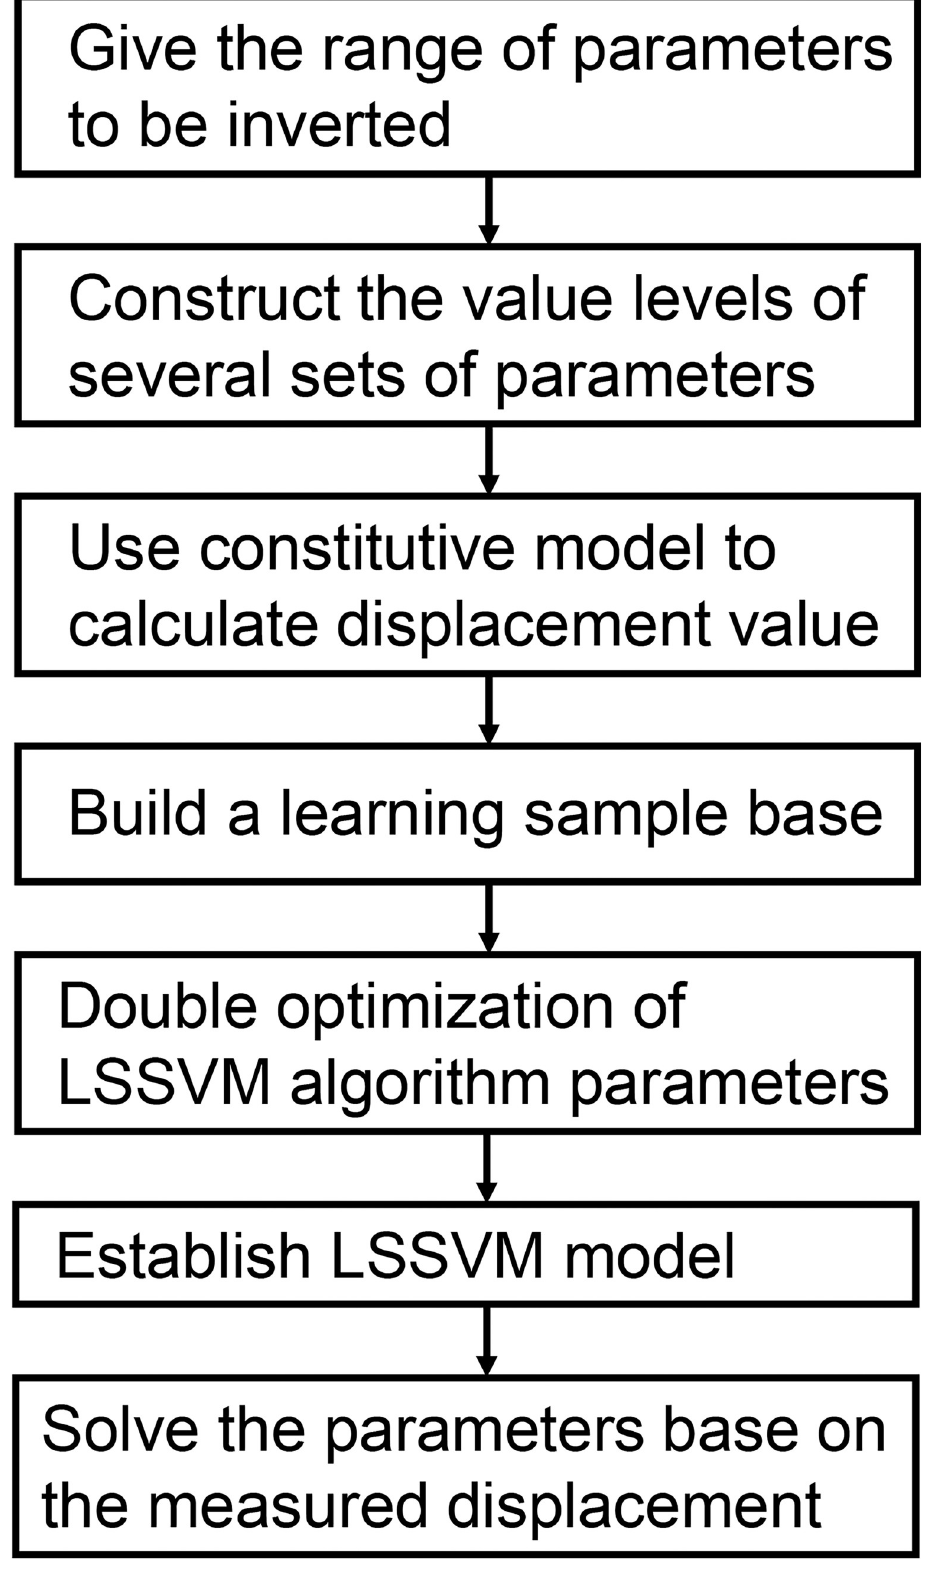
Fig 3. The procedure of implementing the intelligent displacement inversion algorithm in the constitutive model. https://doi.org/10.1371/journal.pone.0275034.g003 PLOS ONE | https://doi.org/10.1371/journal.pone.0275034 September 30,